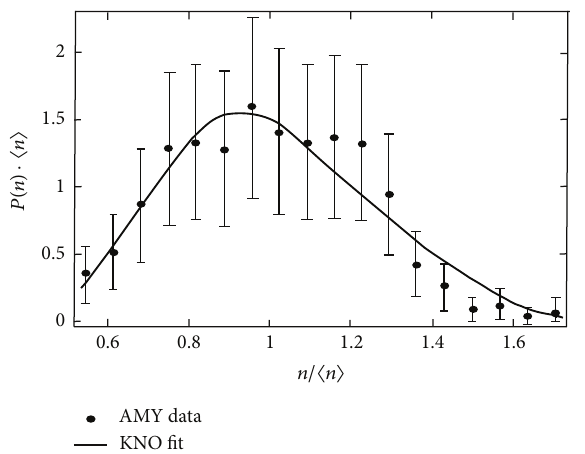
Figure 4: Charged multiplicity distribution due to AMY data based on KNO scaling.